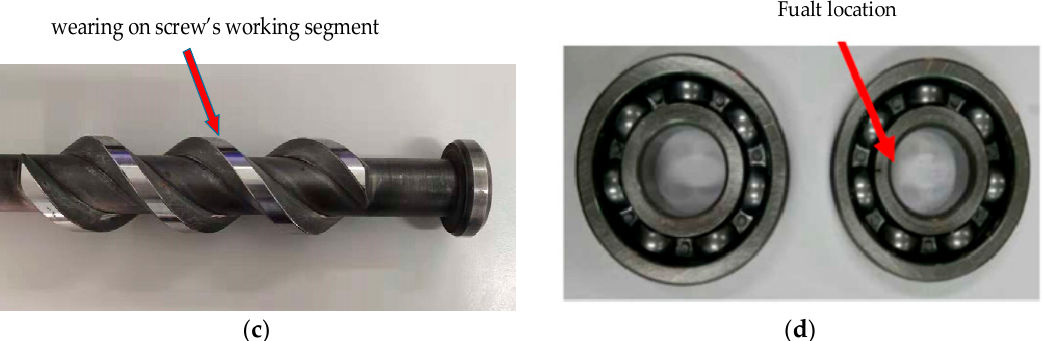
Figure 9. ( a ) Experiment rig; ( b ) Sensor location; ( c ) Fault screw; and, ( d ) Fault rolling bearing.